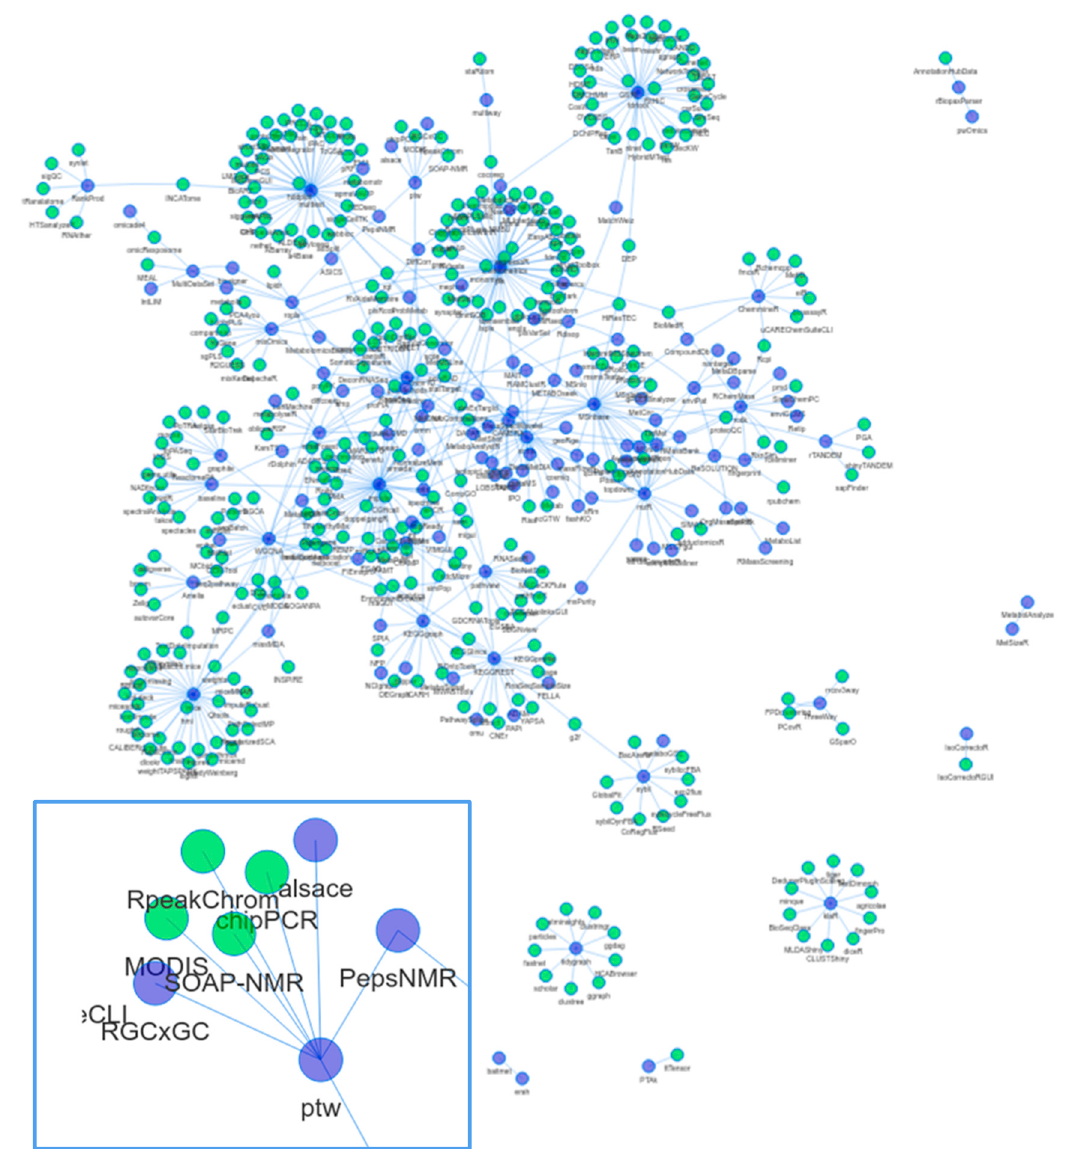
Figure 2. Dependency network of R packages. Shown in blue are packages mentioned in the review. Edges connect to packages that depend on another package, as long as they are in CRAN or BioC. Green nodes correspond to packages in CRAN or BioC not covered in the review. The inset shows the neighbourhood of the ptw package. Not shown are (1) infrastructure packages, e.g., rJava, Rcpp; (2) packages from the review without reverse dependencies; and (3) data packages. Some packages from the review are not in current versions of CRAN or BioC. An interactive version of this figure is also available online (rformassspectrometry.github.io / metaRbolomics-book, Appendix 2) and as Supplemental File S2.